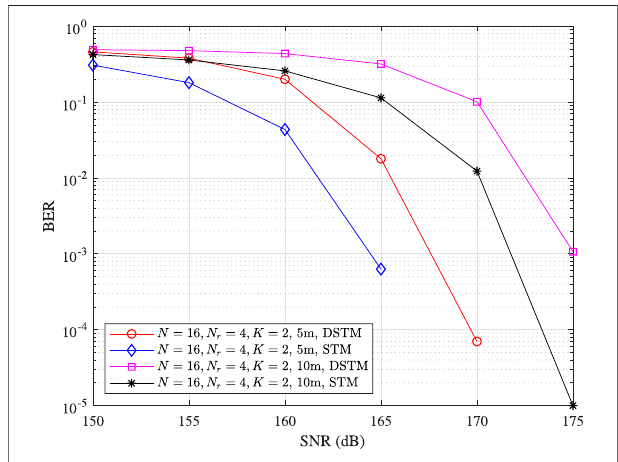
FIGURE 5 | BER comparison between the proposed DSTM and STM. FIGURE 6 | BER comparison between the high-rate DSTM and